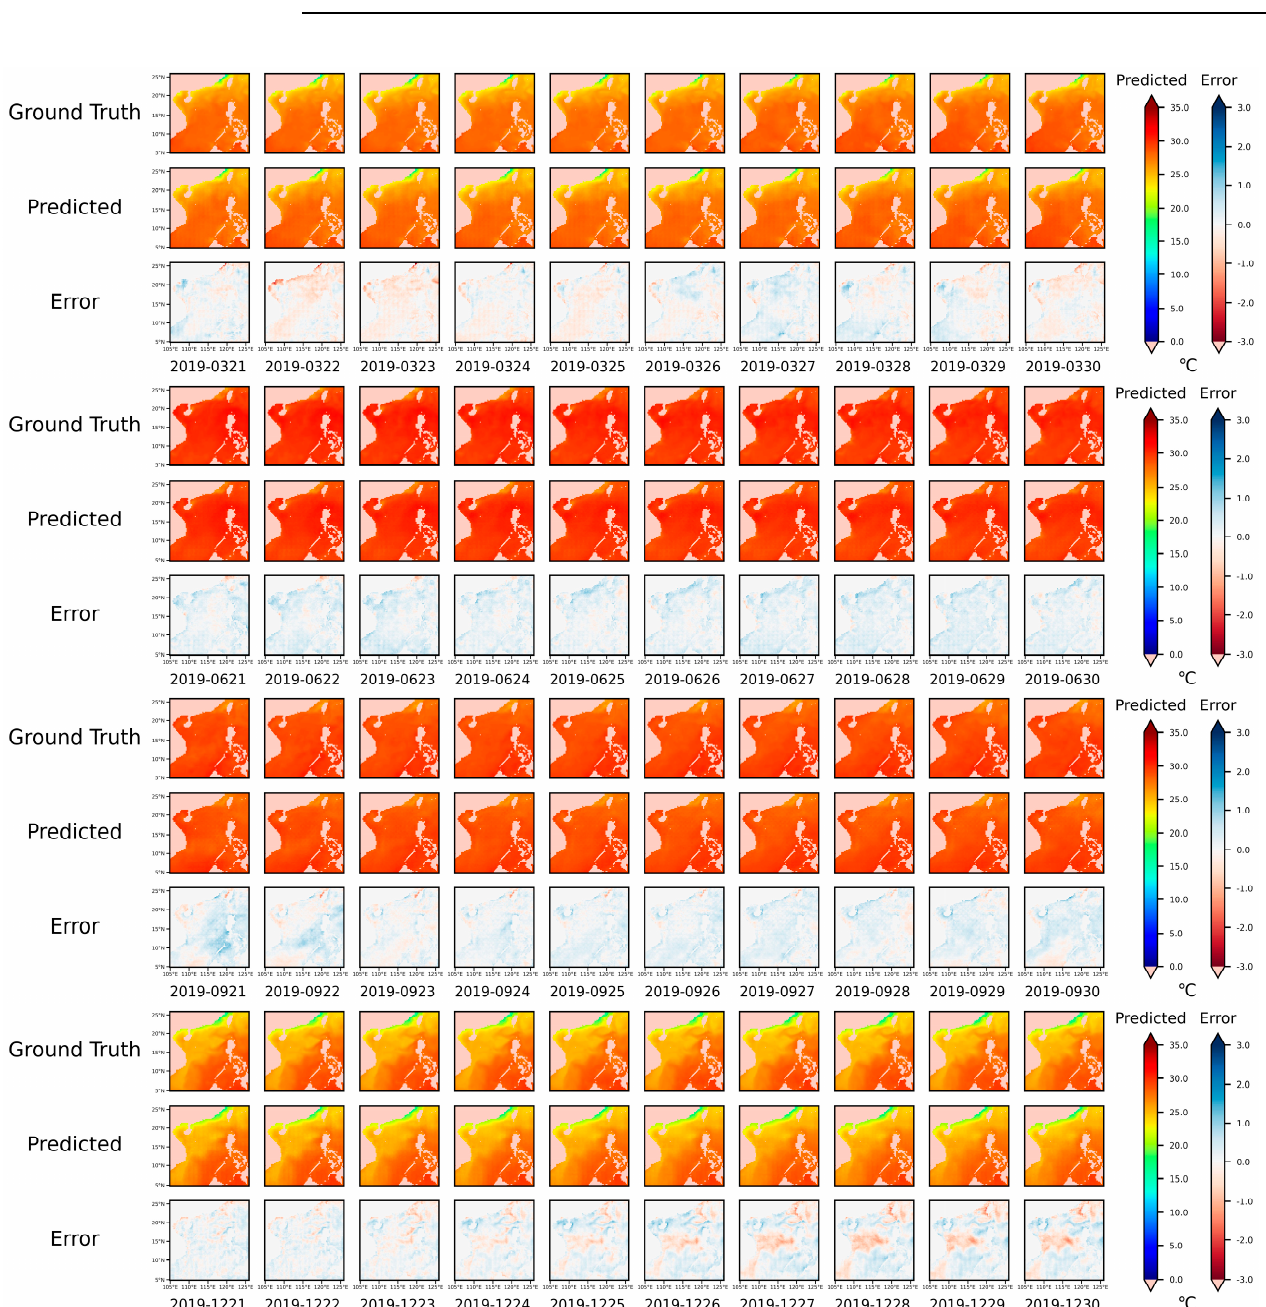
Figure 12. Visualization of the ConvLSTM predicted SST for the next 10